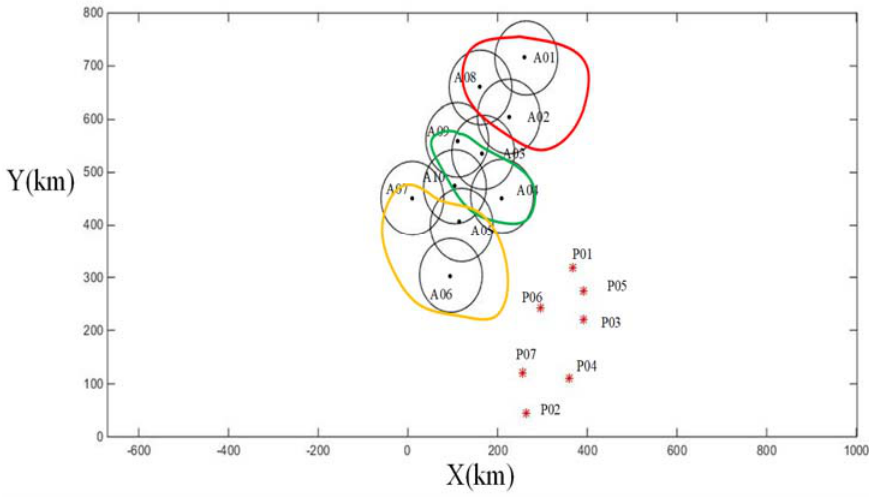
Figure 5. Clustering results of target groups.